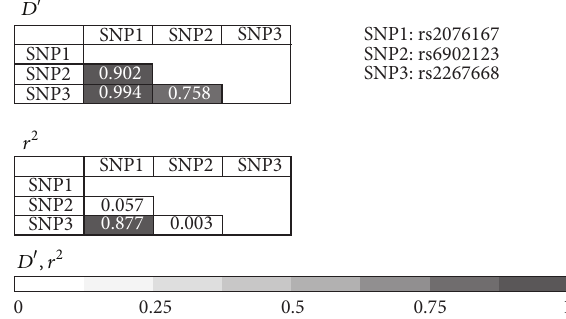
Figure 1: Linkage disequilibrium between the 3 PPARD polymor-